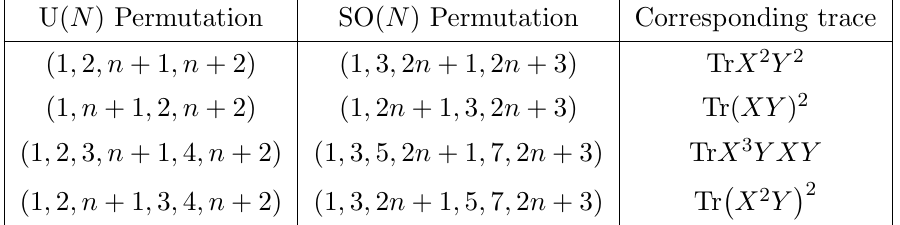
Table 8 . Examples of multi-traces and the permutations which produce them via the SO( N ) contraction (3.6) and the U( N ) contraction